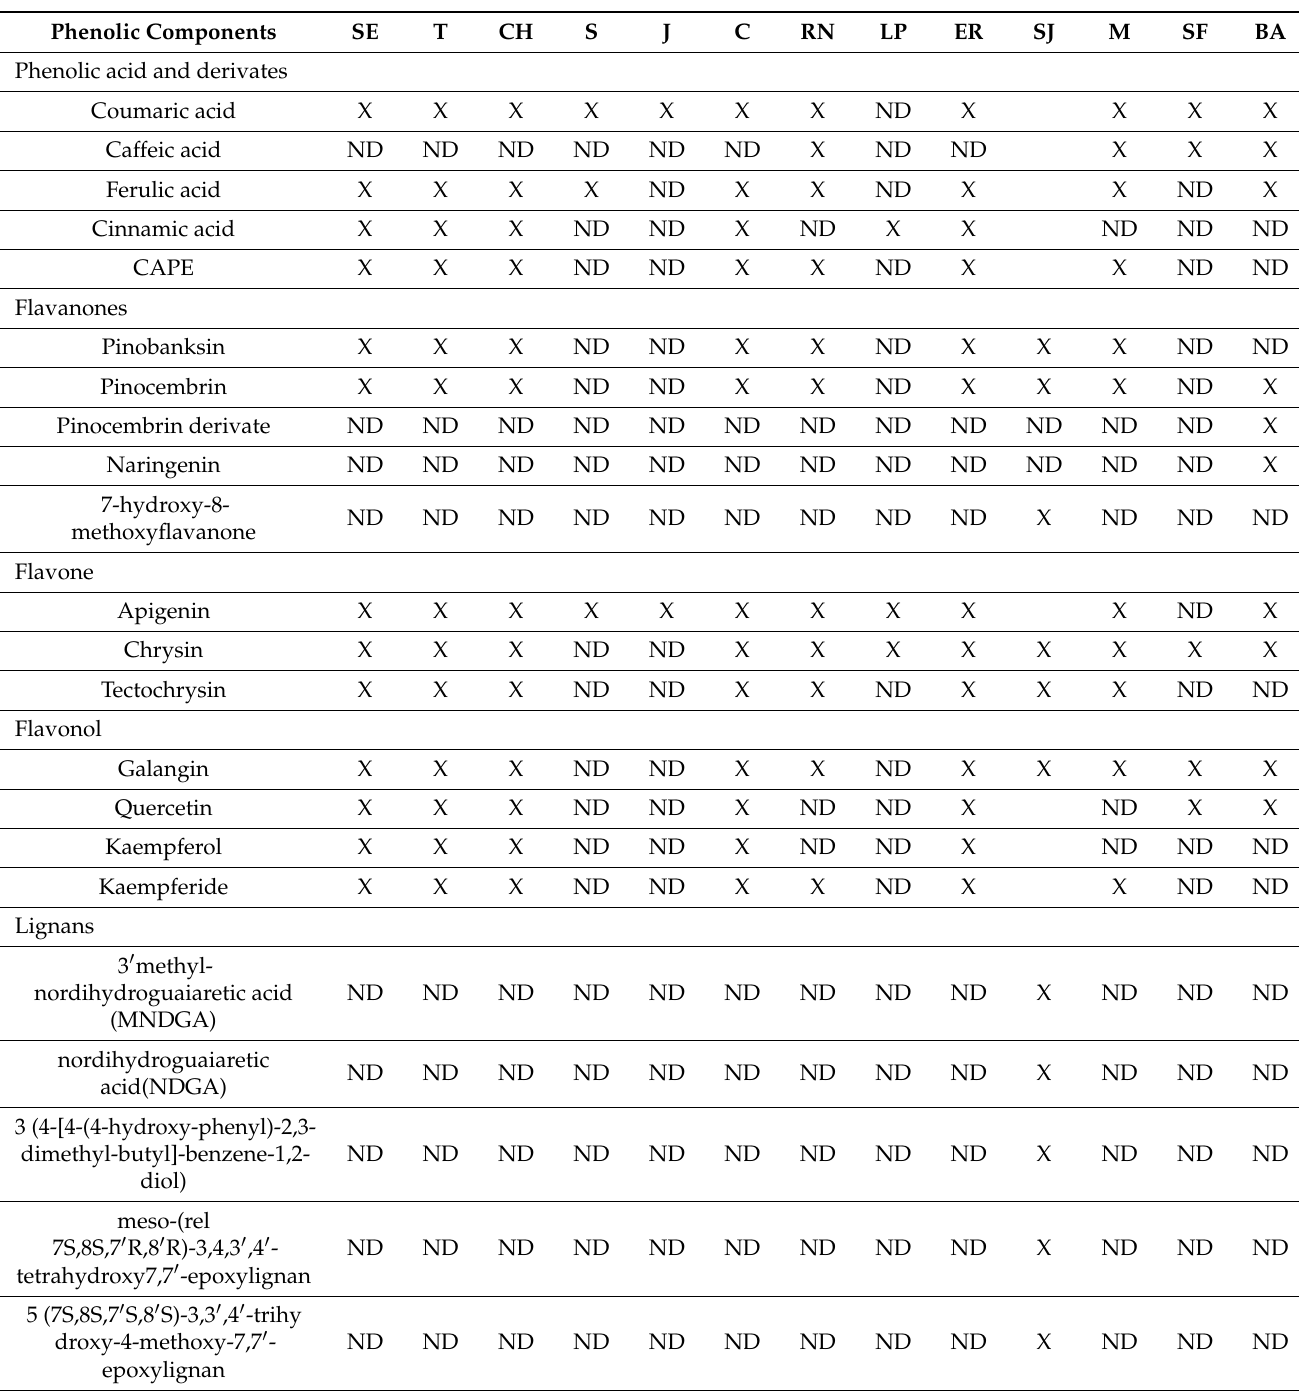
Table 1. Chemical composition of Argentine propolis (province